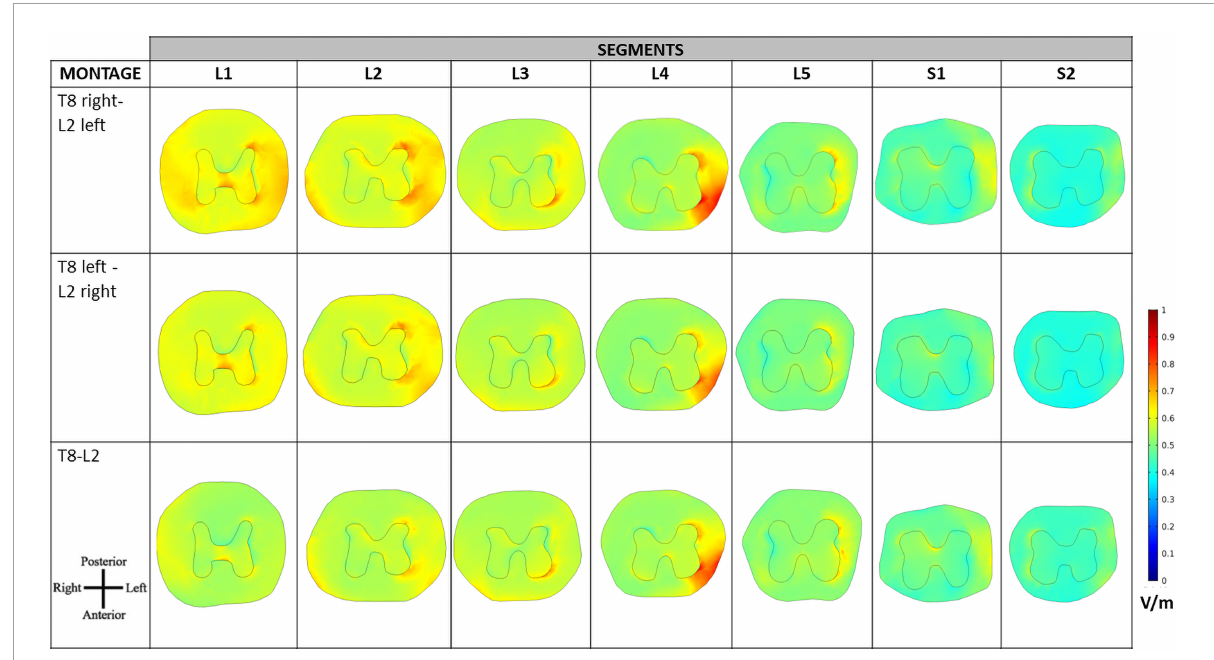
FIGURE5 Electric field (E-field) magnitude distribution in transverse slices of the spinal cord (SC). The orientation of the slices is represented in the bottom left corner and color scale in V/m is represented on the right.